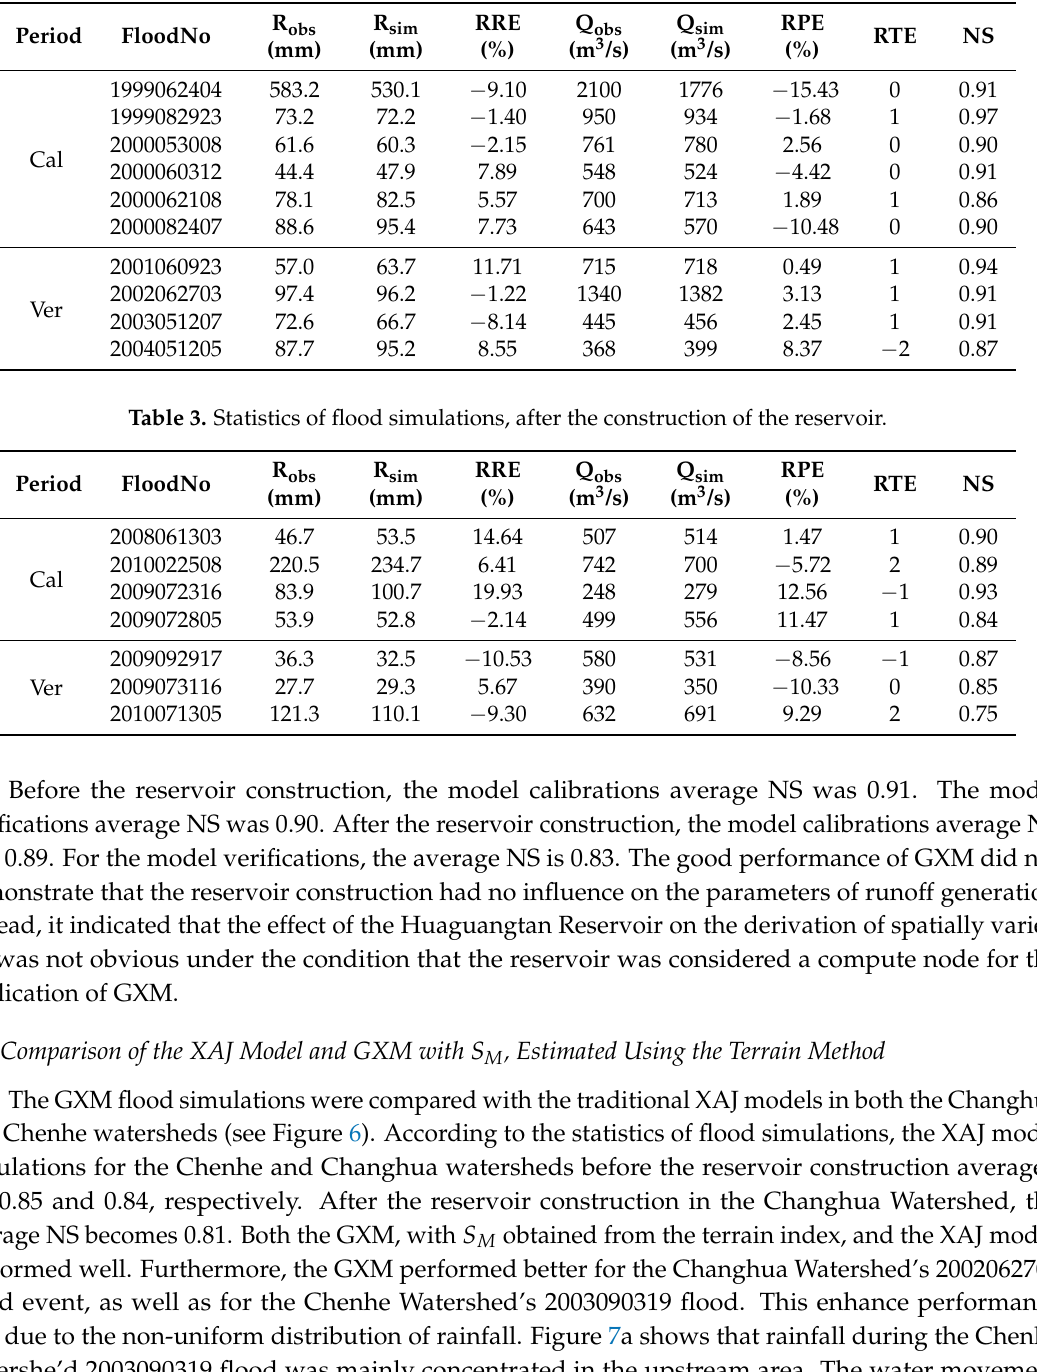
Table 2. Statistics of flood simulations, before the construction of the reservoir.